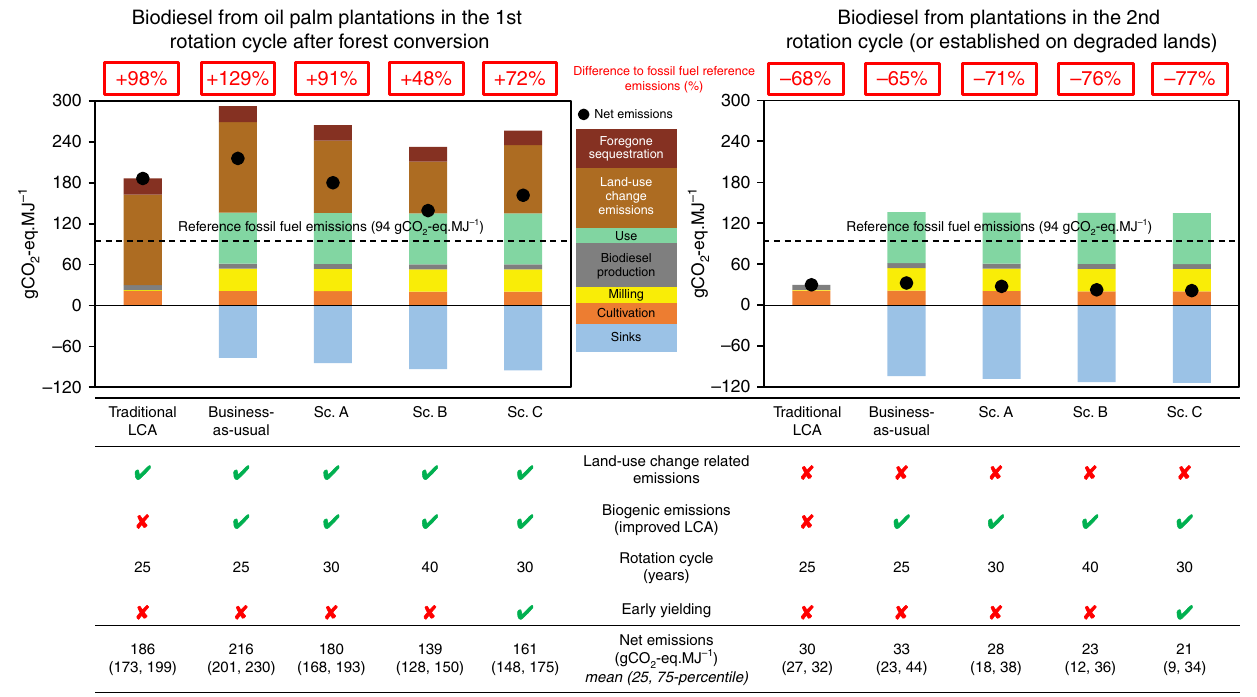
Fig. 2 Life Cycle Assessment of palm-oil biodiesel. Life Cycle Assessment (LCA) of palm-oil biodiesel for fi rst (1st) and second (2nd) rotation cycles with different analysis and management scenarios. The traditional LCA follows a common LCA approach where carbon neutrality is assumed; in contrast, an enhanced LCA taking into account measured greenhouse gas (GHG) fl uxes and biogenic carbon dioxide emissions from product use was applied for all other scenarios. All scenarios assume oil palm cultivation on mineral soil. The business-as-usual scenario assumes an oil palm plantation life cycle of 25 years. The simulated alternative management scenarios assume a life cycle of 30 years (scenario A), 40 years (B), and 30 years with a hypothetical, earlier-yielding oil palm variety (C). The net GHG emissions for each LCA (black dots) are the different GHG emissions over the life cycle (positive values) minus the according sinks (negative values, blue bars). Reference fossil fuel emissions are marked with a black dotted line. The lower table indicates if biogenic emissions, early-yielding varieties and land-use change emissions were considered (green check mark) or not (red cross) for each analysis, and the length of the rotation cycle. See Supplementary Fig. 3 and Supplementary Table 4 for detailed fl uxes and parameters considered in all